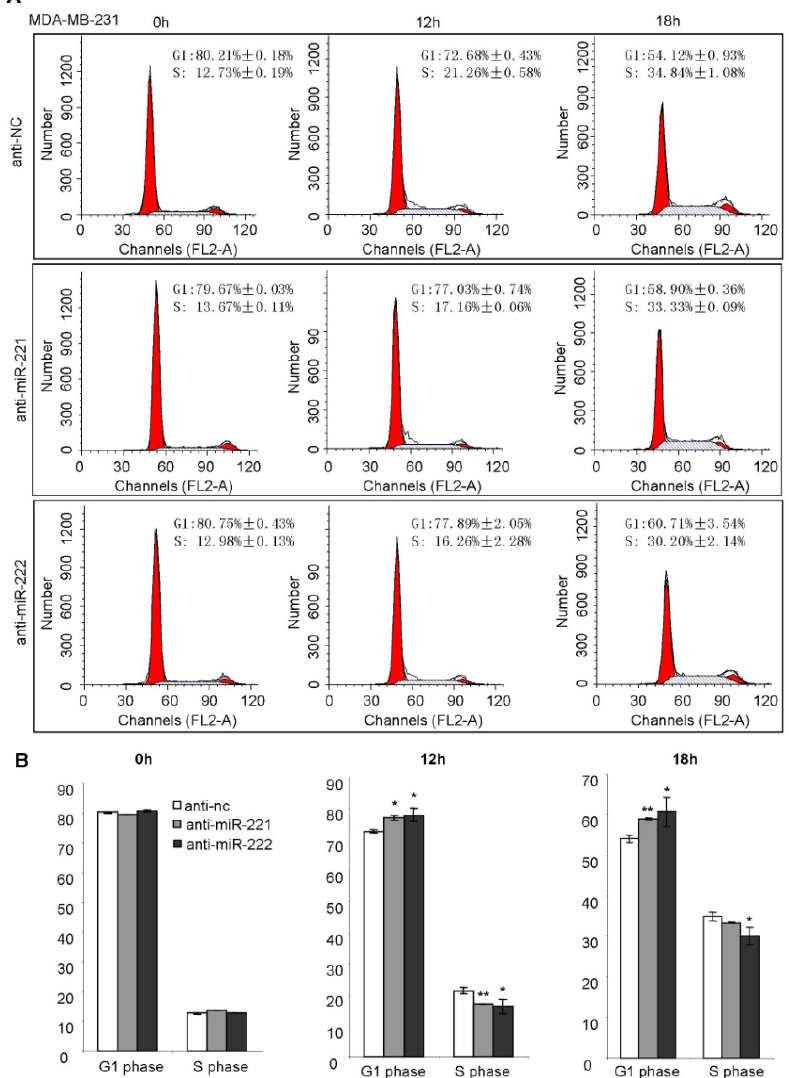
MDA-MB-231 cells. ( A ) Cell cycle analysis on MDA-MB-231 cells at the starved status (0 h) and 10% FBS-released status (12 h and 18 h) showing inhibition of G miRNA both inhibitors targeting miR-221 and miR-222. ( B ) Quantitative analysis of the cell % at the G phase and S phase. Data are mean ± SEM ( n = 3). * p < 0.05, ** p < 1